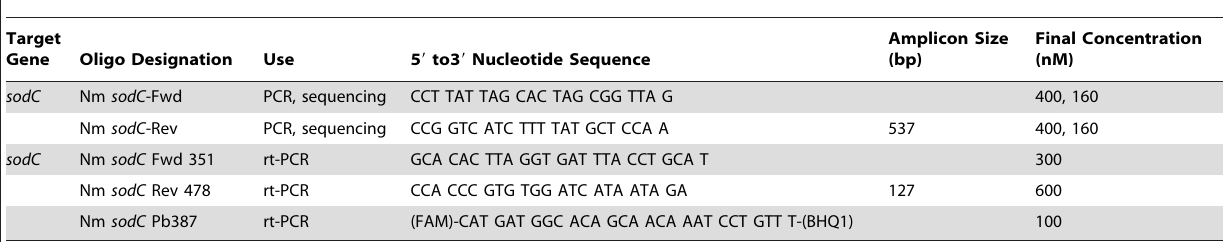
Table 4. Primers and probe used in this